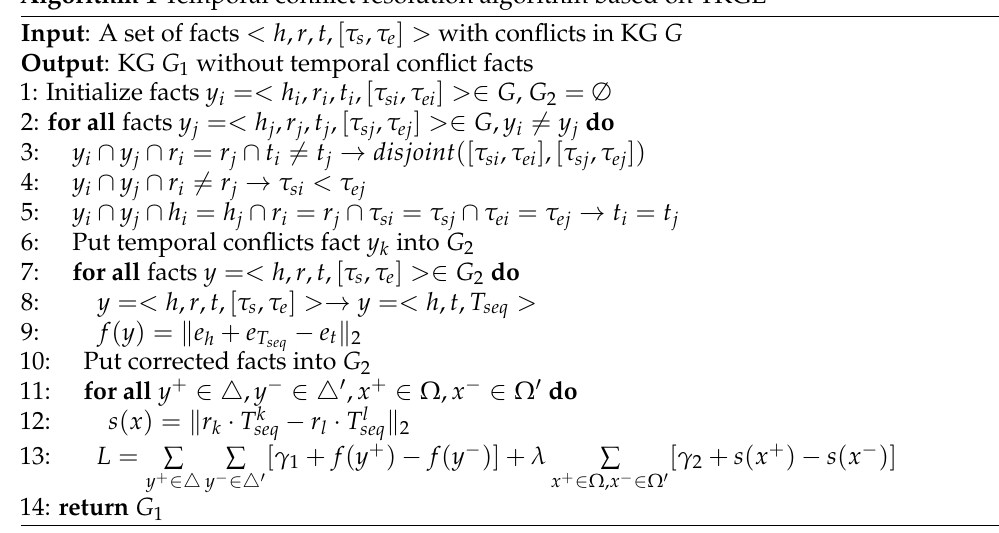
Algorithm 1 Temporal conflict resolution algorithm based on